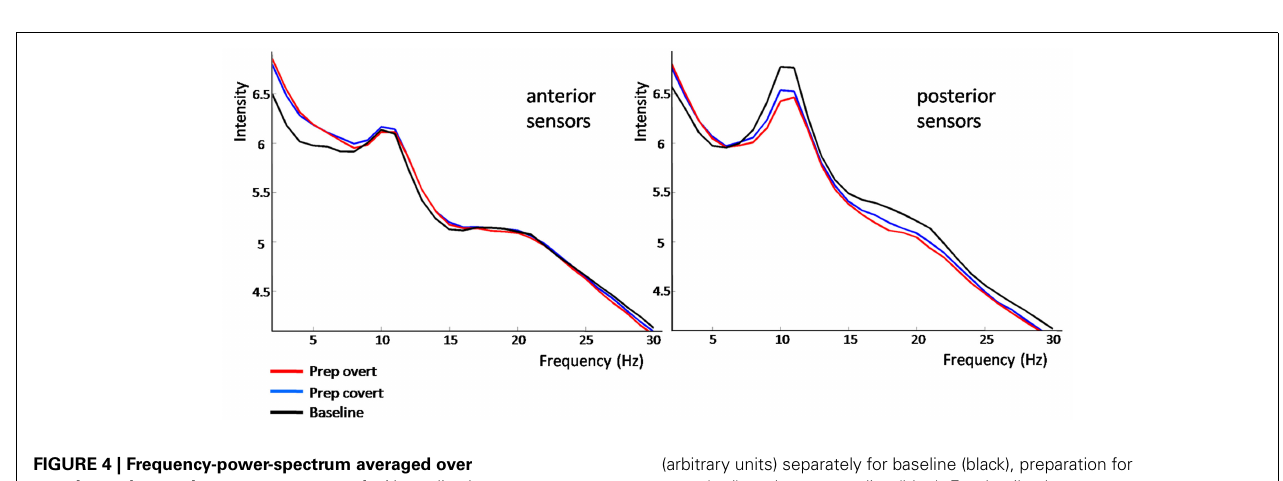
FIGURE 4 | Frequency-power-spectrum averaged over anterior and posterior sensors, separately. Normalized power in frequencies from 2 to 30Hz is plotted against intensity